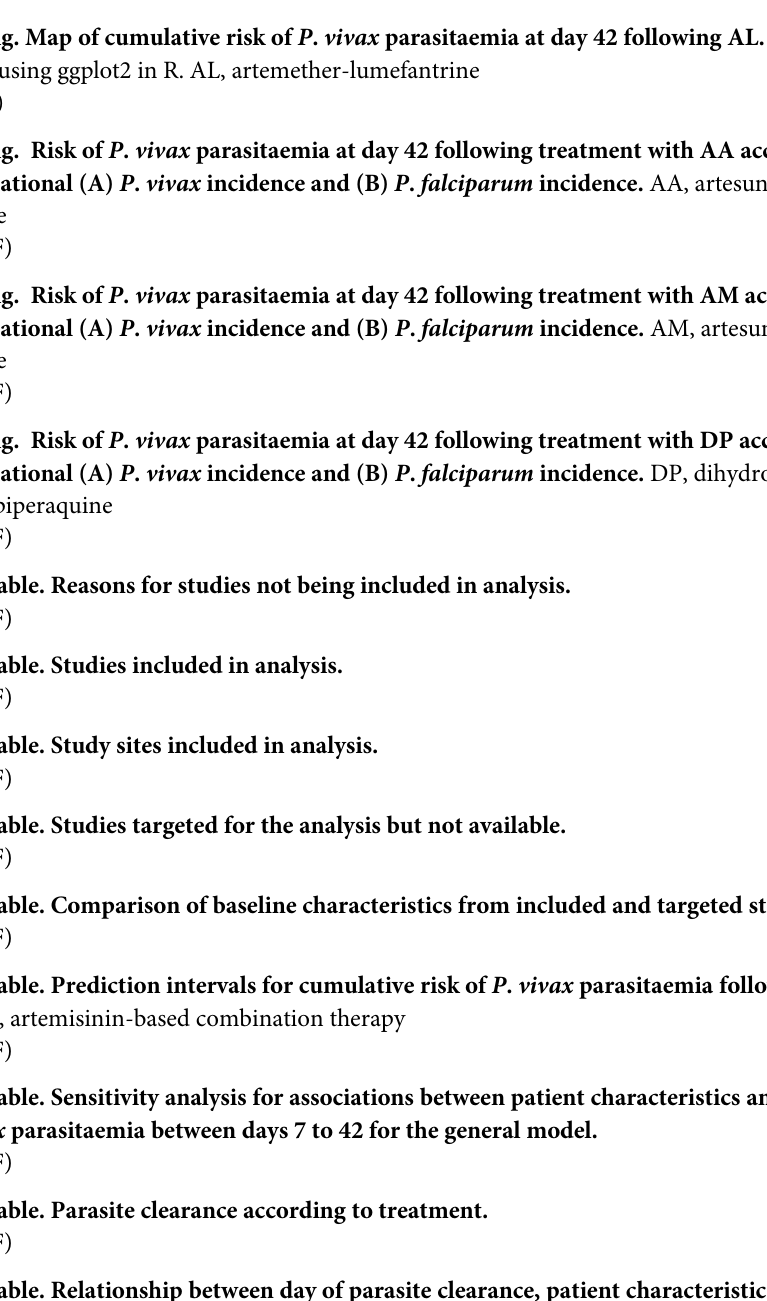
S1 Fig. Map of study-site locations. Map created using ggplot2 in R. (TIF) S2 Fig. Map of cumulative risk of P . vivax parasitaemia at day 42 following AL. Map cre- ated using ggplot2 in R. AL, artemether-lumefantrine S3 Fig. Risk of P . vivax parasitaemia at day 42 following treatment with AA according to subnational (A) P . vivax incidence and (B) P . falciparum incidence. AA, artesunate-amodia-